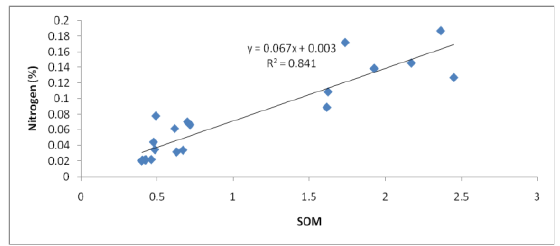
Figure 4 : The relationship between SOM content and nitrogen content